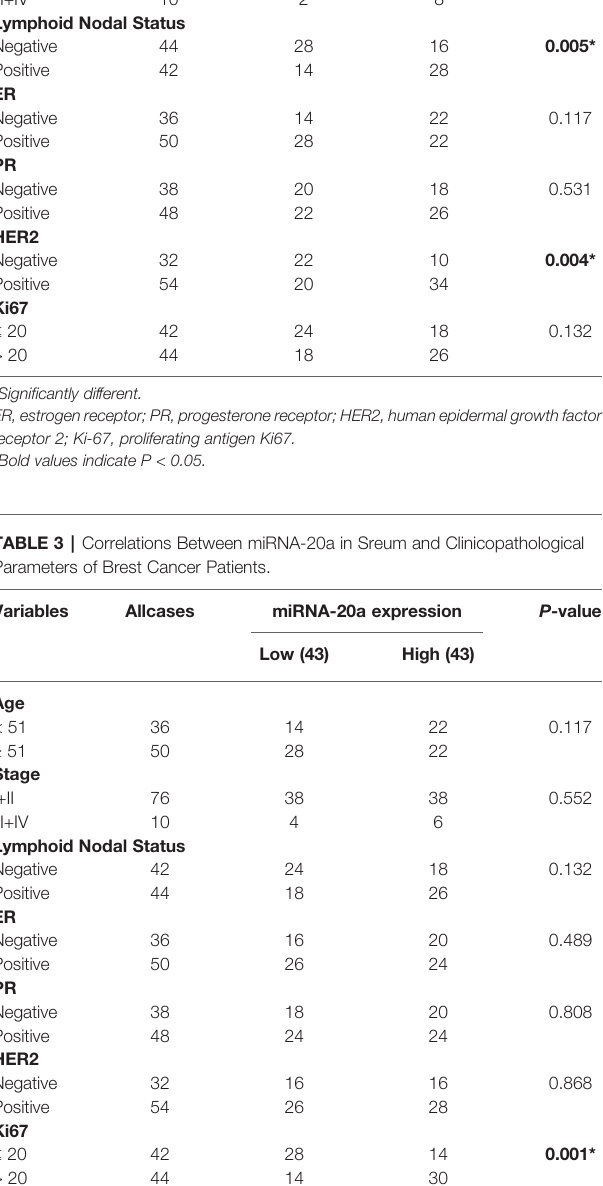
*Signi fi cantly different. ER,estrogenreceptor;PR,progesteronereceptor;HER2,humanepidermalgrowthfactor receptor 2; Ki-67, proliferating antigen Ki67. *Bold values indicate P <